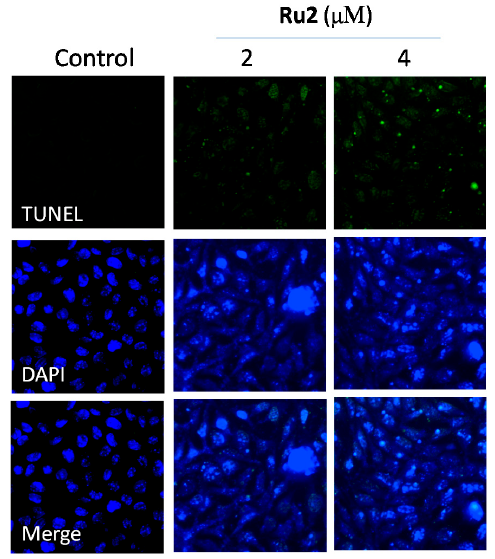
Figure 5. Apoptotic DNA fragmentation and nuclear condensation induced by Ru2 as determined via a TUNEL-DAPI co-staining assay (magnification, 200×). Cells were treated with Ru2 for 24 h. TUNEL